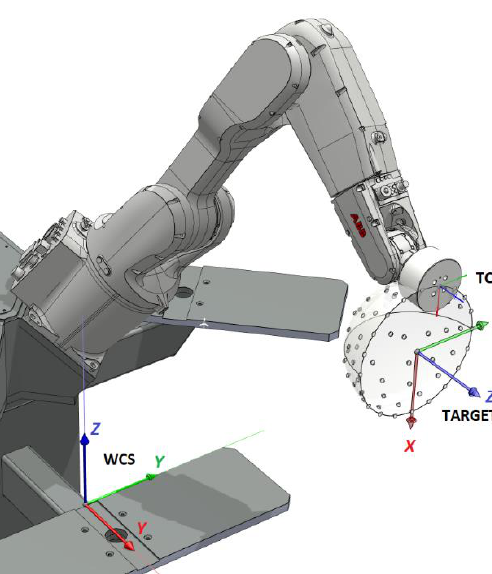
Figure 6. Robot workspace and measured target.